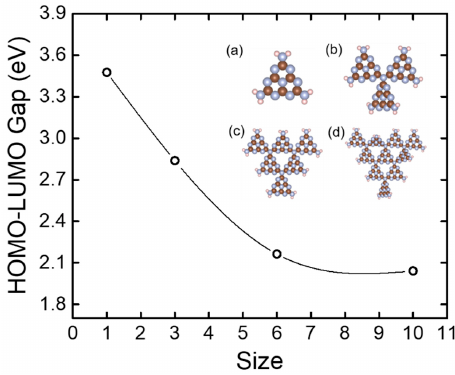
Figure 1. Calculated HOMO–LUMO gap vs g-C 3 N 4 structures with varying sizes. Insets show the optimized configurations of ( a ) g-C 3 N 4 -1; ( b ) g-C 3 N 4 -3; ( c ) g-C 3 N 4 -6; and ( d ) g-C 3 N 4 -10. Brown, blue, and pink spheres represent C, N, and H, respectively.